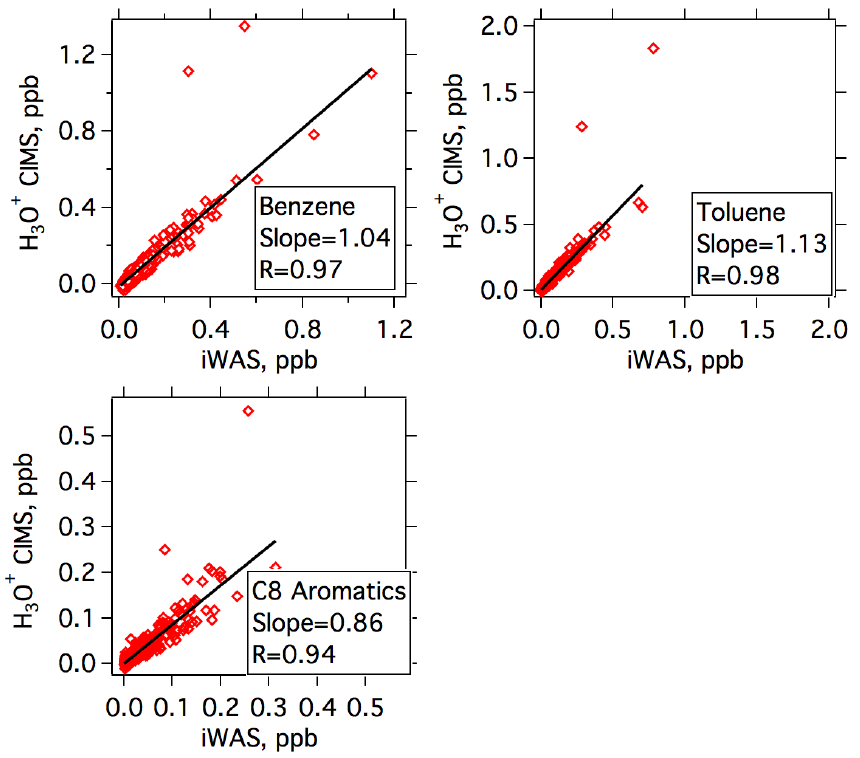
Figure 11. Comparison of measured mixing ratios of benzene, toluene and C8 aromatics between the H 3 O + ToF-CIMS and iWAS (Lerner et al., 2016) during the SONGNEX